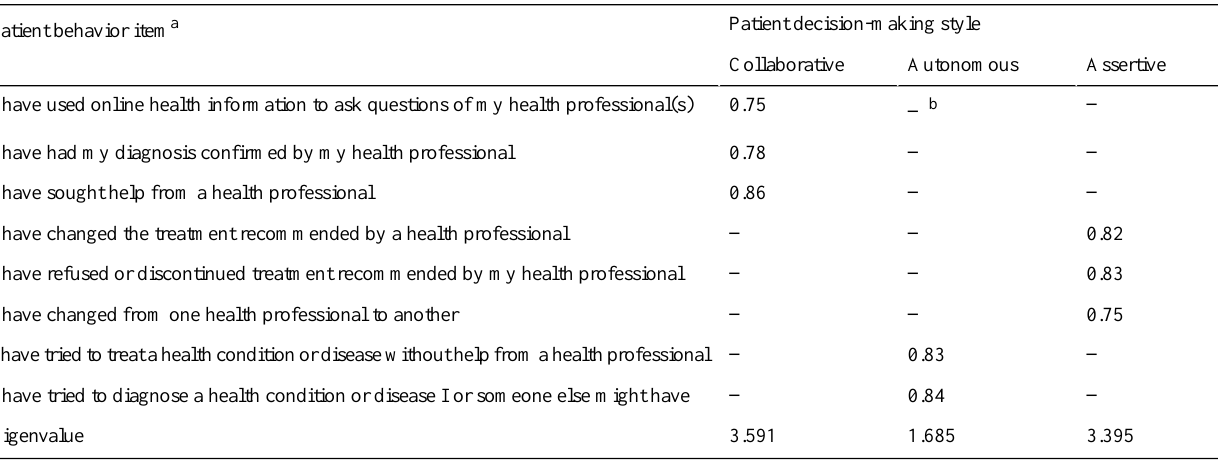
Table 1. Items and factor loadings of exploratory factor analysis.